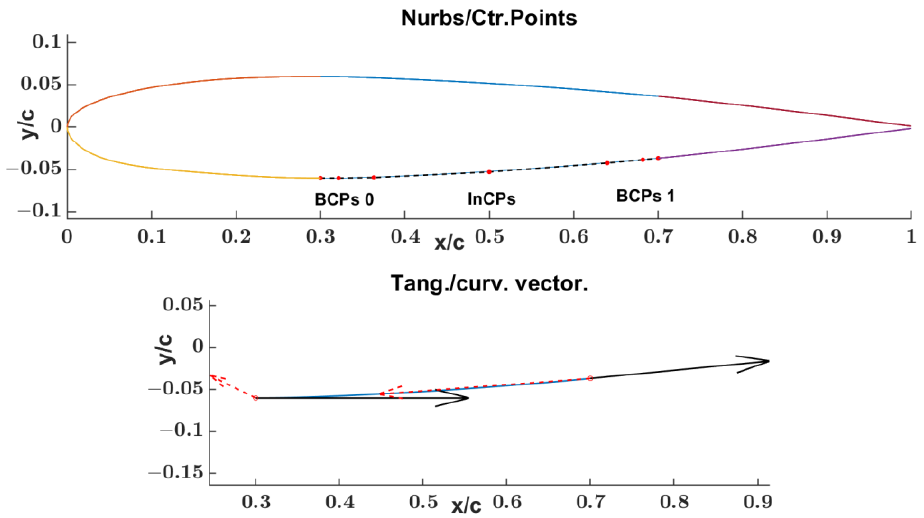
Figure 8. Central Box segment 5 BCPs, InCPs & C ′ (tangent), C ′′ (curvature) vectors with black and red colors respectively.